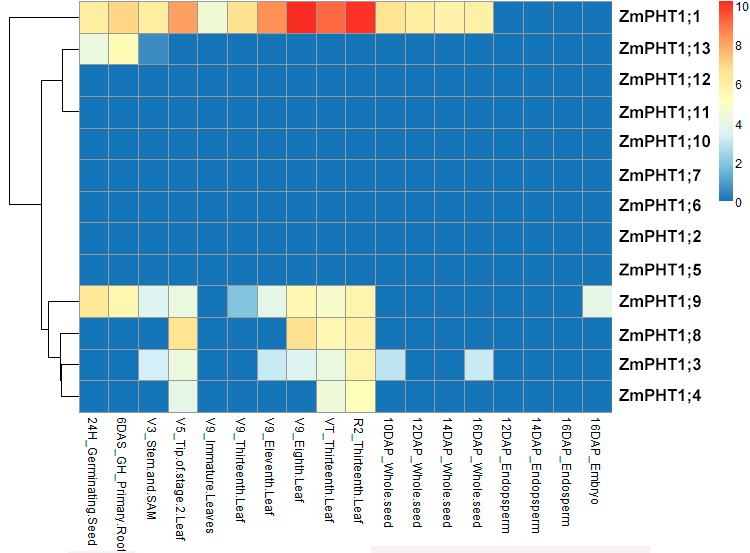
Figure 4. Heat map of maize ZmPHT1 genes. The expression level of each ZmPHT1 genes can be estimated based on the scale to the right. Red indicates high expression level; yellow indicates medium expression level; and blue indicates low expression level. H, hours; DAS, days after sowing; GH, greenhouse; V, vegetative; DAP, days after pollination; VT, vegetative tasseling; R, reproductive.